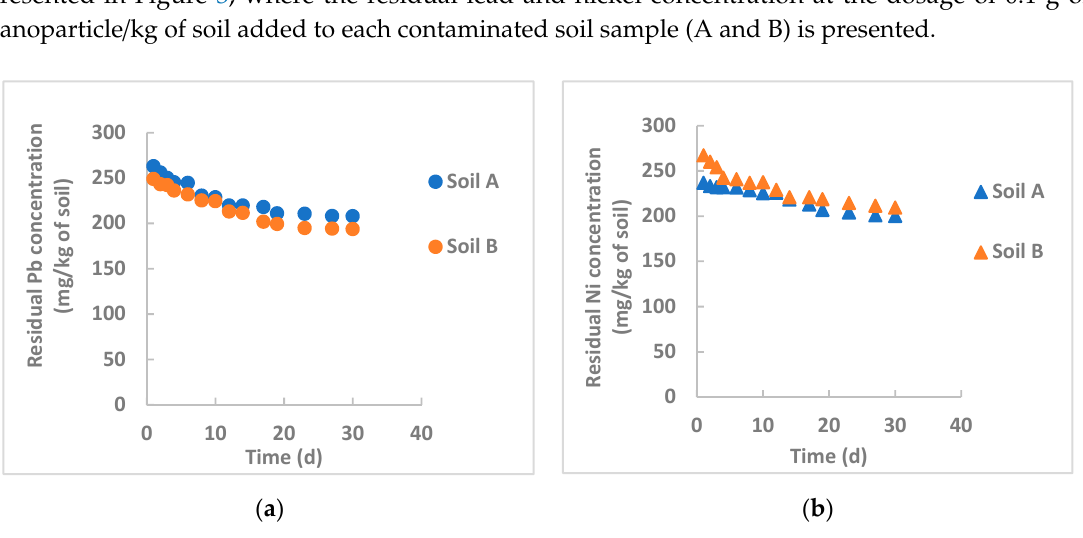
( b ) Figure 4. Remediation of nZVI particles synthesized using neem leaves (dosage: 0.1 g/kg of soil): ( a ) lead removal; ( b ) nickel removal.